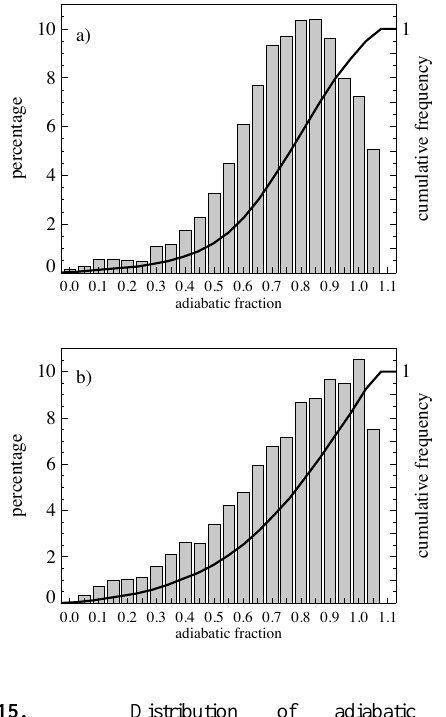
Fig. 15. Distribution of adiabatic fraction (LWP retrieved /LWP adiabatic ) for (a) coupled and (b) decou- pled boundary layers. Only clouds with thicknesses exceeding 100m were included, for a total N of